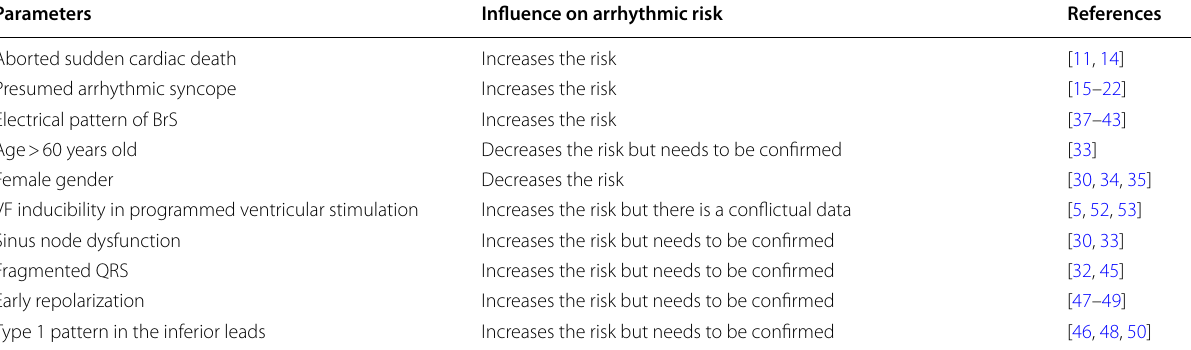
Table 1 Summary table of SCD risk stratification components and their references